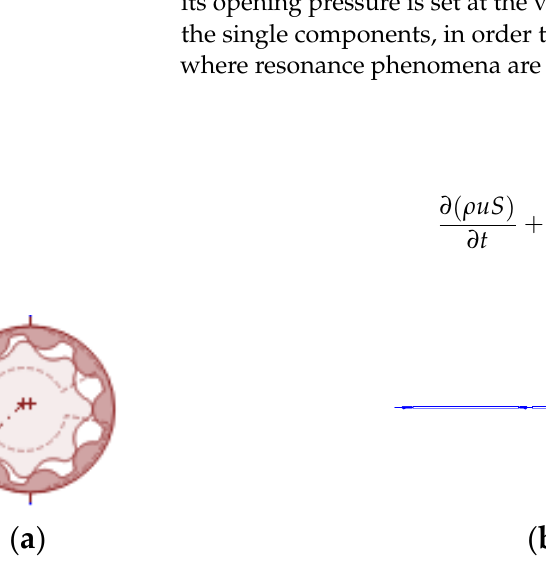
Figure 4. Components submodels: ( a ) Gerotor gear pump (HCDGP0); ( b ) Pipeline (HLLWx); ( c ) Relief valve (RV010).